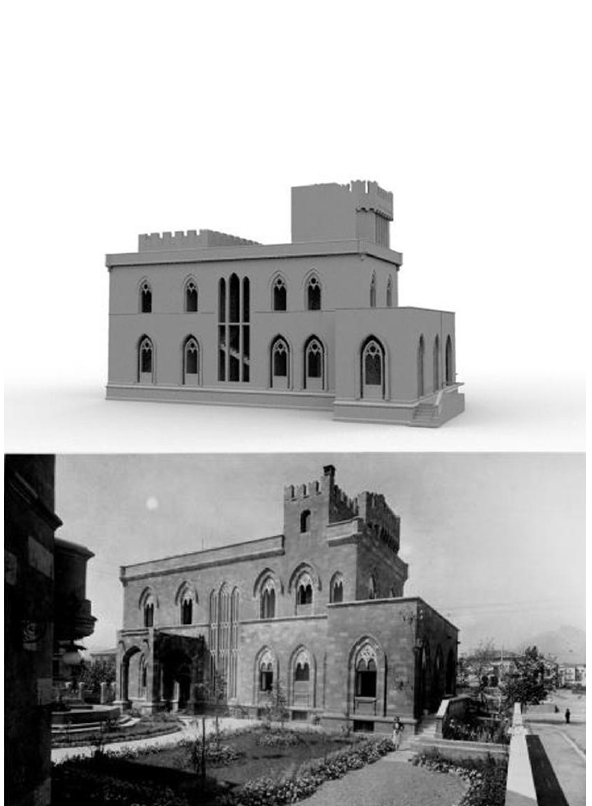
Figure 5 . Three-dimensional reconstruction and relative historical photo.